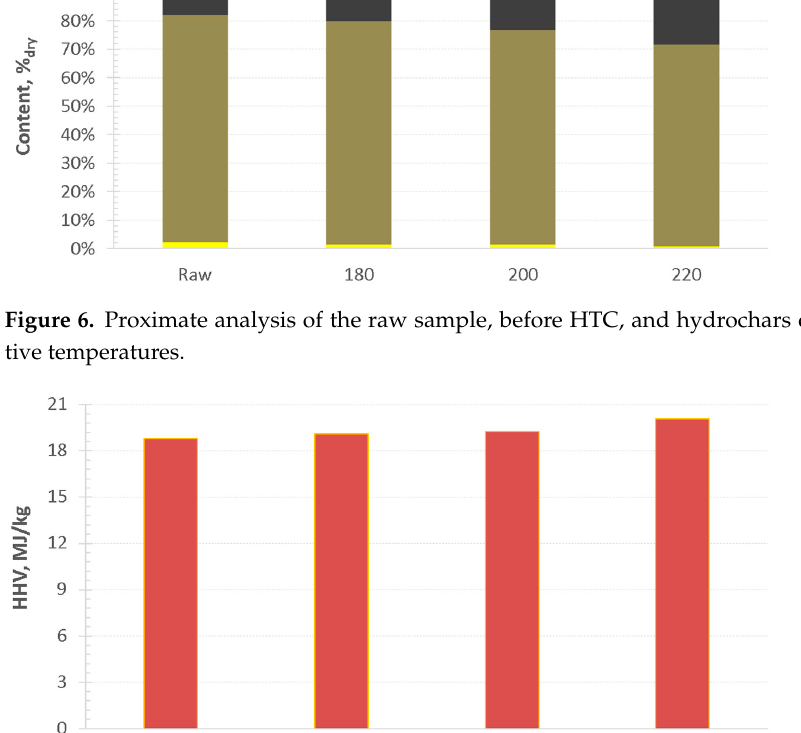
Figure 7. Higher heating values of the raw sample, before HTC, and hydrochars obtained at respec- tive temperatures.